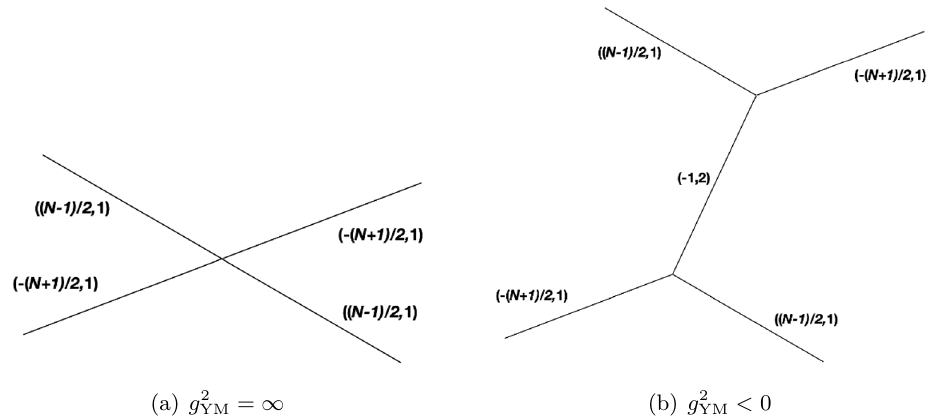
Figure 4 . ( p, q ) web for N = 1 SU( N ) gauge theory with N